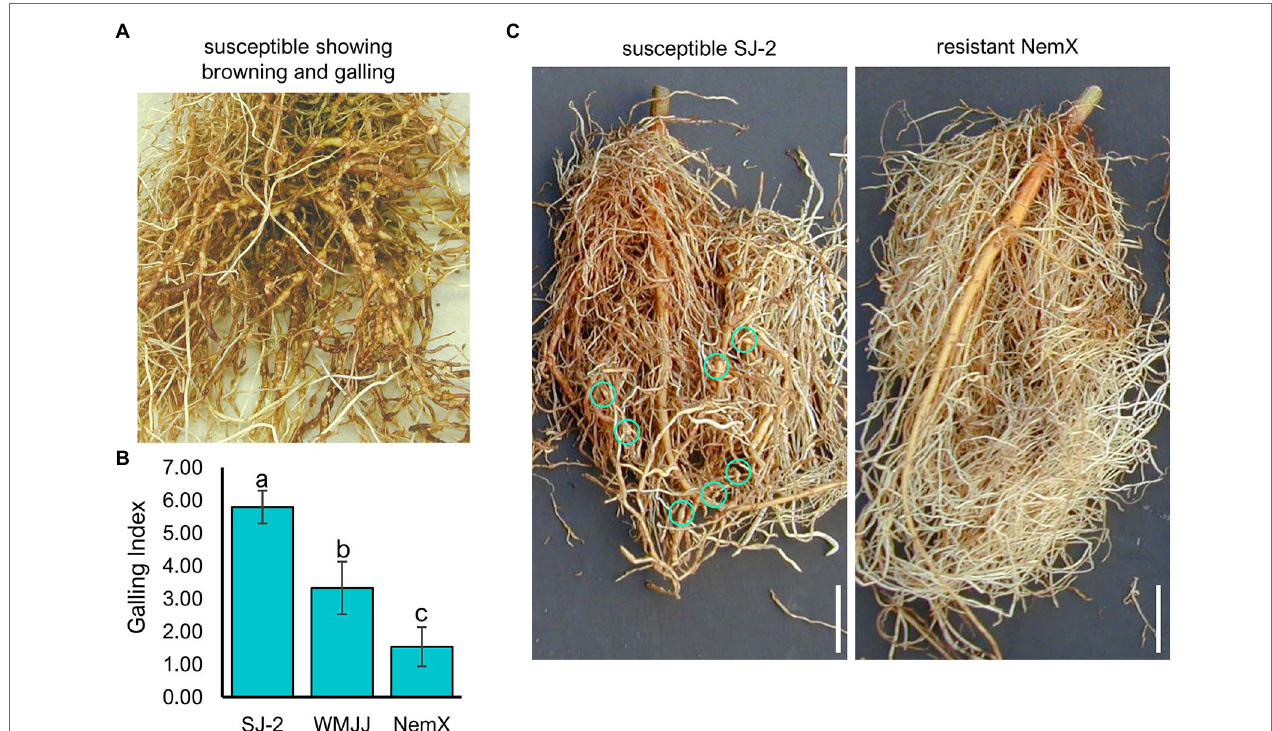
FIGURE 1 | The cotton cultivars SJ2, WMJJ and NemX present low, mild and high resistance to RKN infection, respectively. (A) Severe symptoms of nematode infection in the root system of a susceptible plant. (B) Distribution of mean Galling Index (GI) for the cotton cultivars Acala NemX (NemX, RKN-resistant), Acala SJ-2 (SJ2, RKN-susceptible), Wild Mexico Jack Jones (WMJJ, moderately RKN-resistant). Different letters represent difference in susceptibility to RKN ( Meloidogyne incognita – RKN). GI: 0–10 scale on Y-axis. (C) Images depicting RKN-infested roots of NemX and SJ2 evaluated at 60 days. Blue circles indicate the presence of root galls. Scale bar: 5